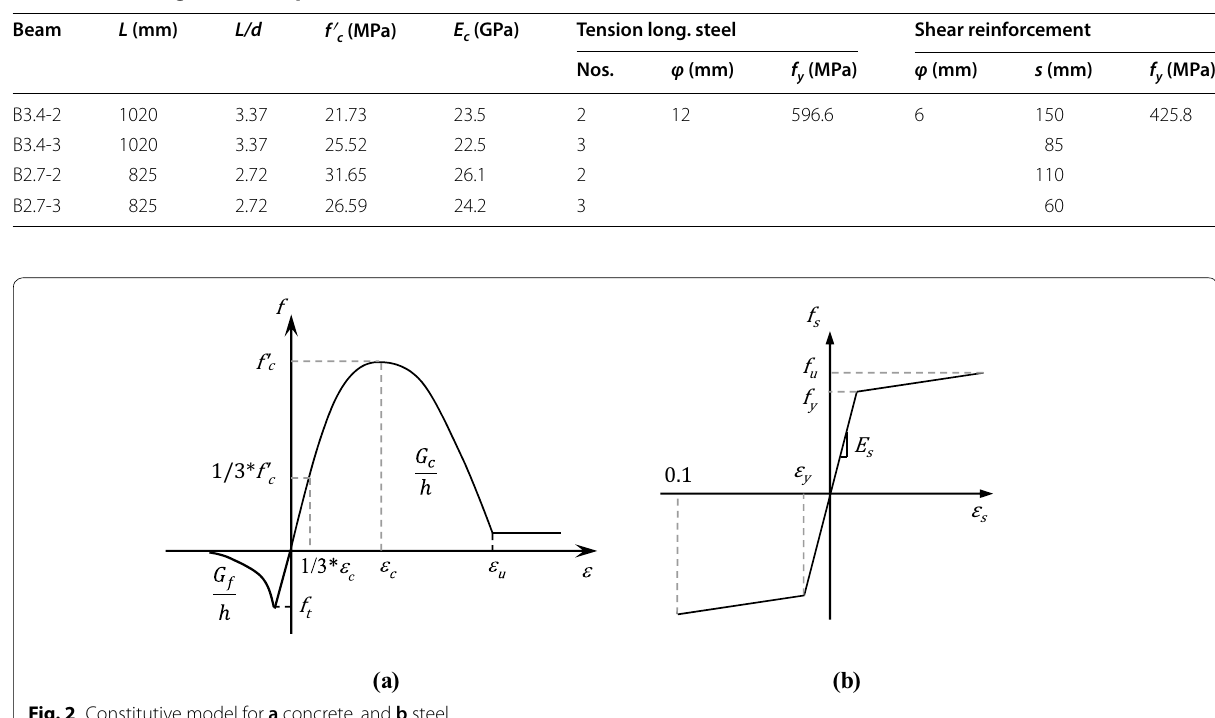
Table 1 Detailing of tested specimen. (Modified from Nabilah and Koh 2017).